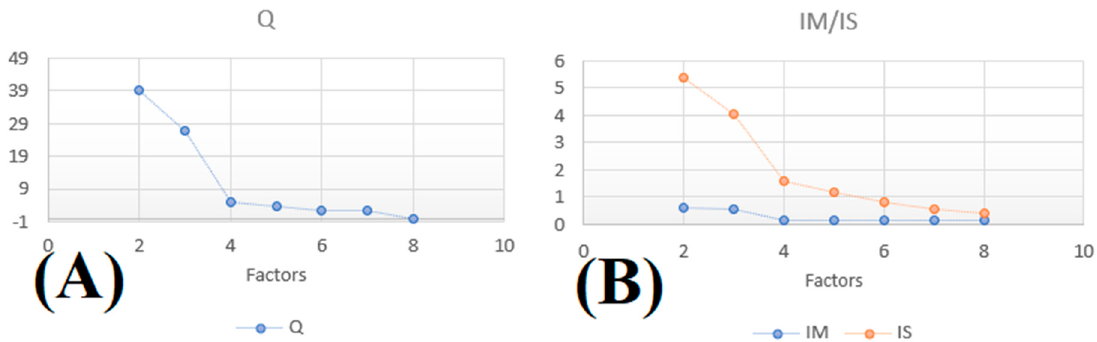
Figure A1. Determination of optimal factor with the ( A ) residual sum of squares Q, ( B ) maximal mean of residual (IM), and maximal standard deviation of residual (IS).